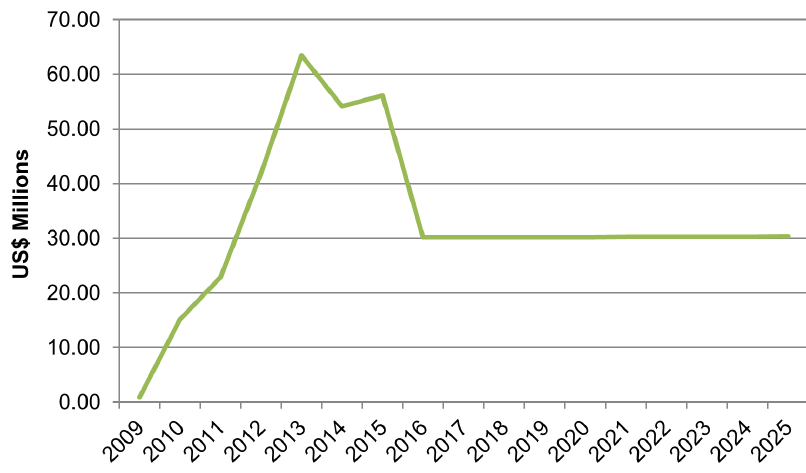
Figure 4. Additional annual cost of scaling up VMMC in Tanzania (2009–2025).